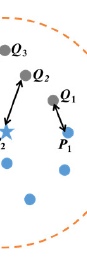
Figure 3. Nearest neighbor among unassigned points.